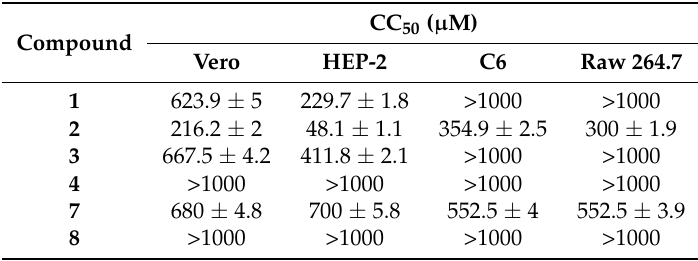
Table 1. Cytotoxic activity of compounds 1 – 4 and 7 – 8 against Vero and selected tumor cell lines a . Compound